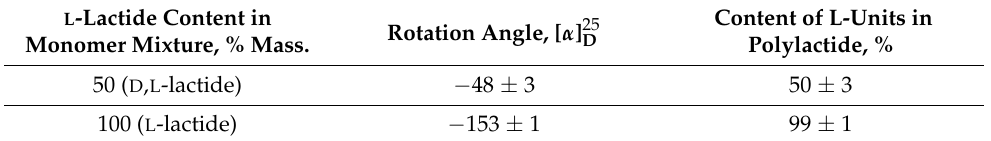
Table 3. Polylactide polarimetry results.